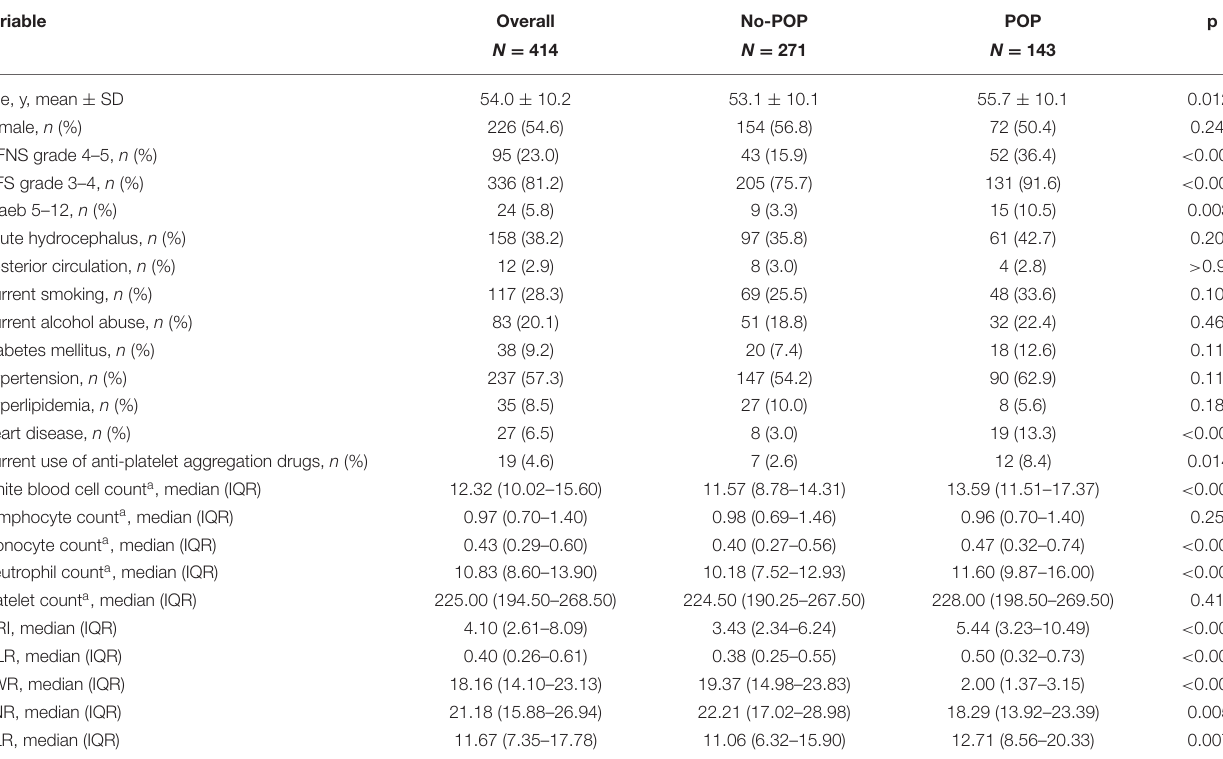
TABLE 5 | Baseline characteristics and inflammatory biomarkers in the surgical clipping (SC) group. Variable